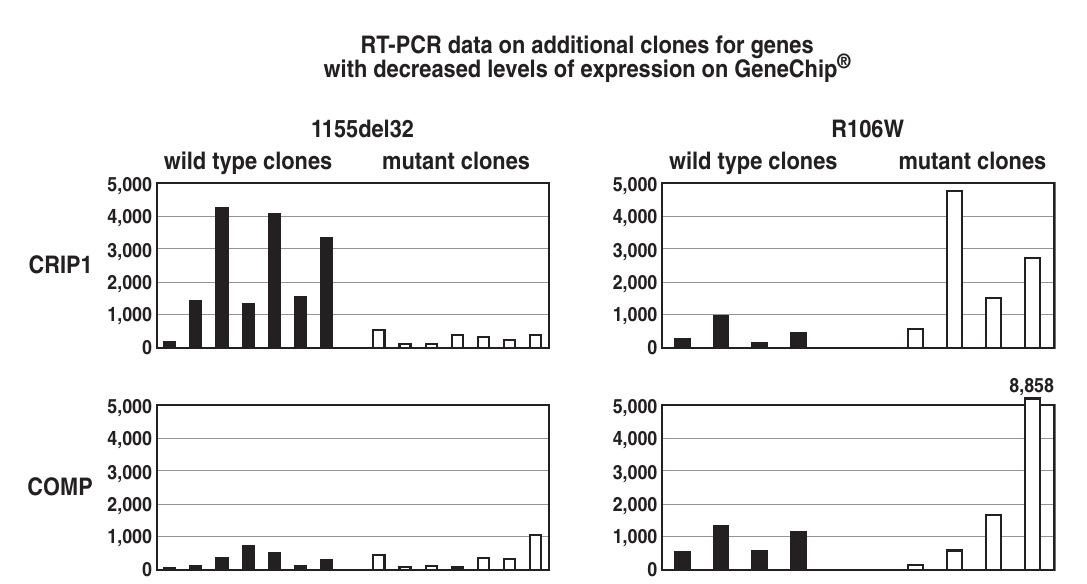
Figure 4 Expression levels of five genes in additional fibroblast clones, not used for GeneChip studies, from two Rett individuals. Left: seven mutant and seven wild-type MeCP2 expressing clonal fibroblast cell strains with the 1155del32 mutation. Right : four mutant and four wild-type MeCP2 expressing clonal fibroblast cell strains with the R106W mutation. Expression values are raw numbers generated from RT-PCR and are for comparative purposes